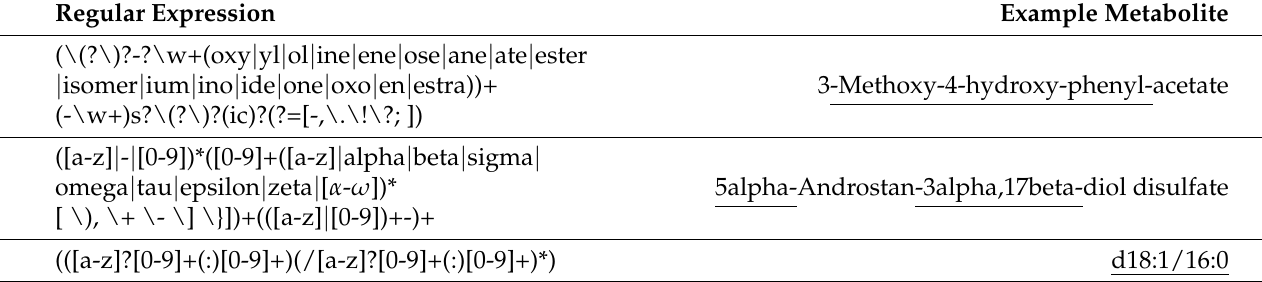
Table A1. Examples of regular expressions used in the rule-based annotation pipeline. Example metabolites that each regular expression matches are shown on the right; the matching parts of the entities are